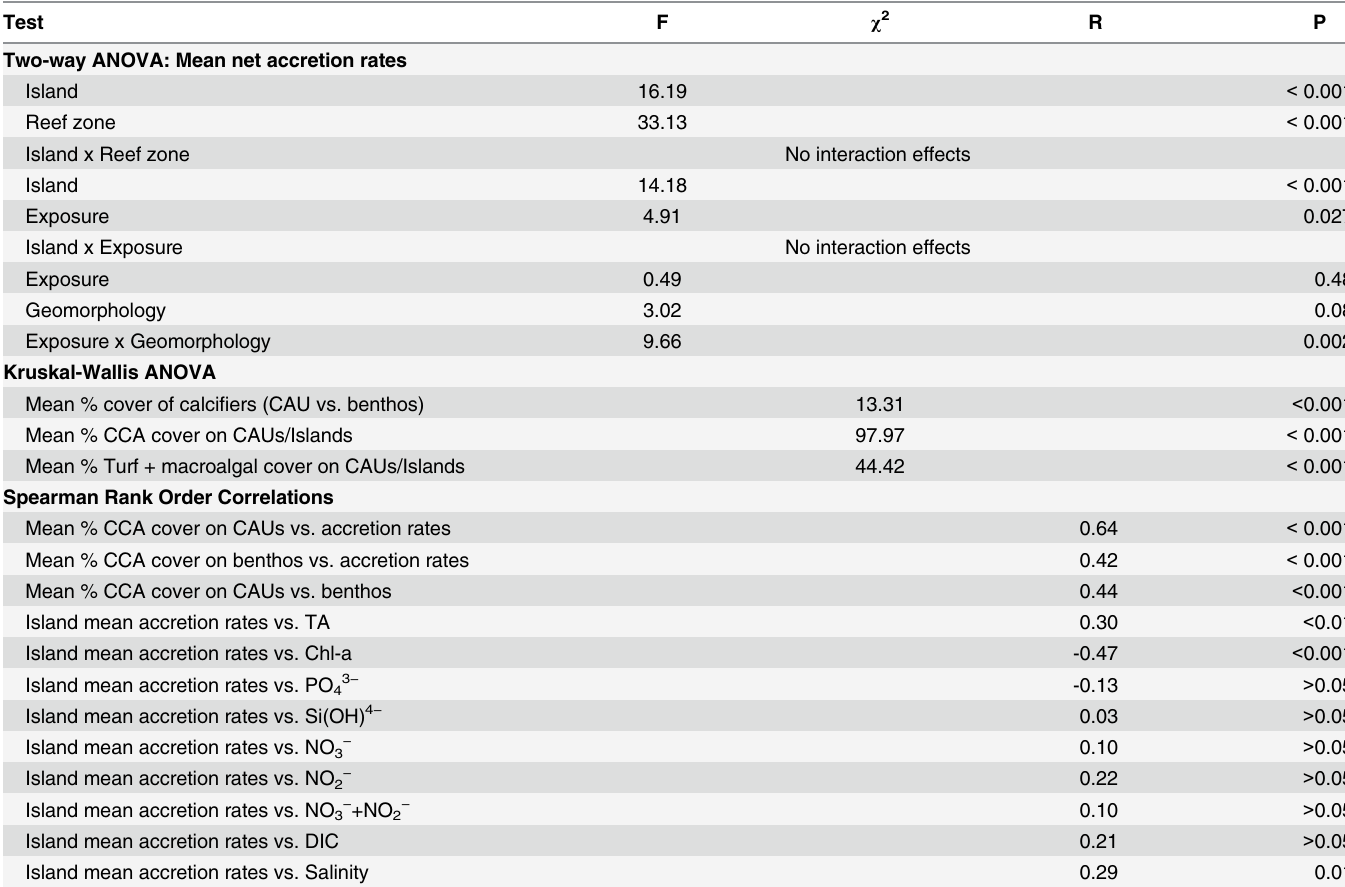
Table 4. Summary results (F, χ 2 , R, and P values) of all independent ANOVA and correlation statistical tests run to analyze accretion, percent cover, and water chemistry